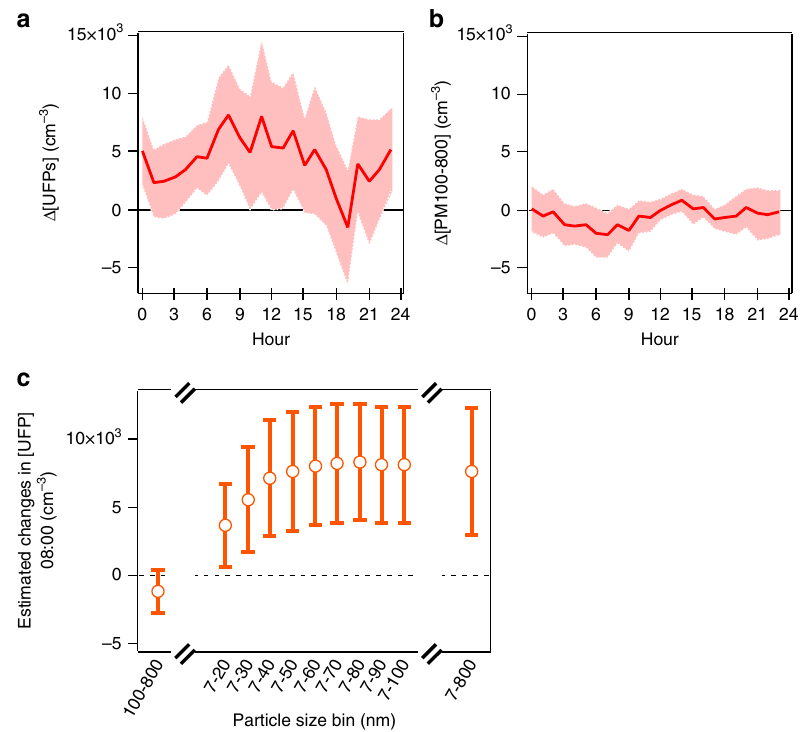
Fig. 4 Estimated changes over weekday diurnal cycle. a 7 – 100 nm and b 100 – 800 nm particle concentration levels, over the weekday diurnal cycle, associated with a 50-percentage-point rise in gasoline use in the fl ex-fuel fl eet, from 30 to 80%. For clarity, for every hour of the day we plot the 95% CI for the gasoline share ’ s association with the 7 – 100 nm size range a , and the 95% CI for the gasoline share ’ s association with the 100 – 800 nm size range b . c Opening the 7 – 20 nm size bin towards 800 nm, and comparison to the 100 – 800 nm bin, for the weekday morning hour of 08:00. For clarity, for 08:00 we plot the CI for the gasoline share ’ s association with every size bin. Source: Speci fi cations reported in Supplementary Table 8 B , D , with sample period restricted to the summer/fall months of January to May 2011 and trend included as seasonality control (same speci fi cations as Table 2 for 7 – 20 nm